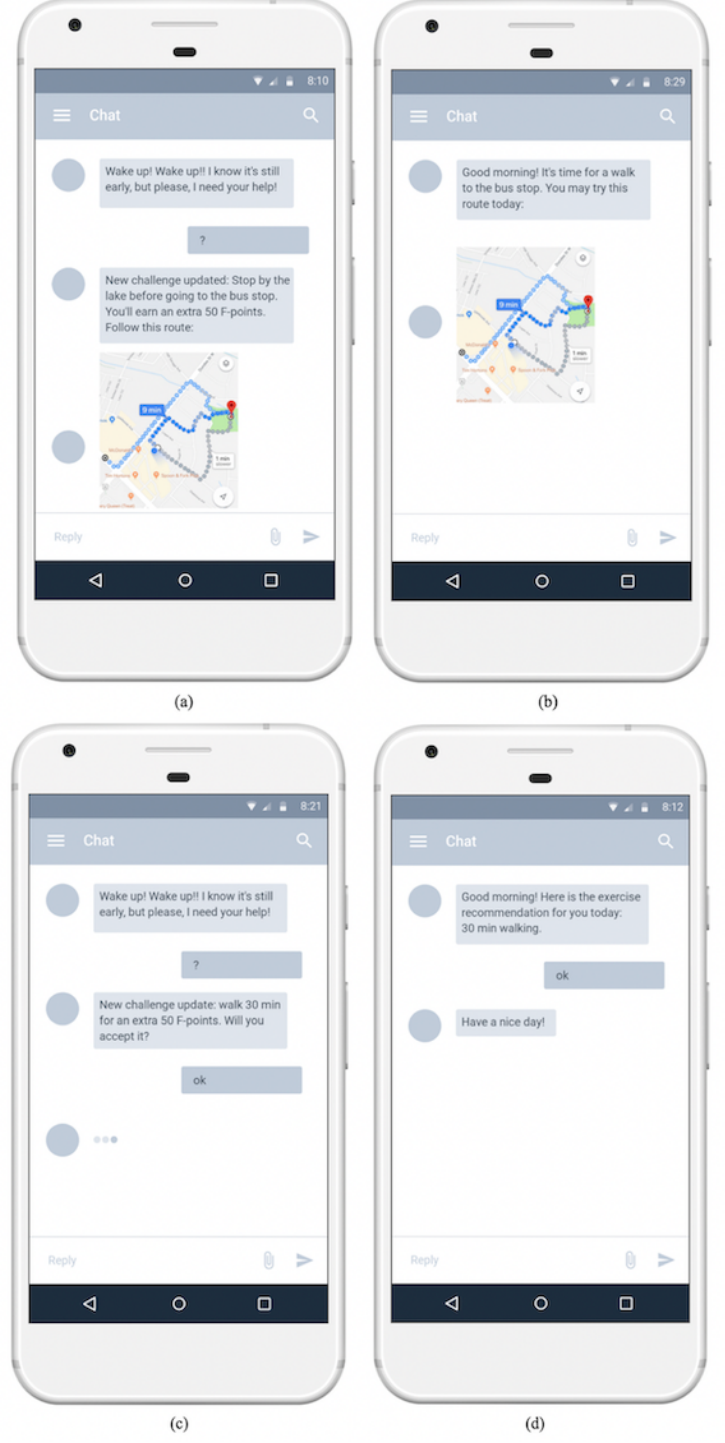
Figure 6. Example of recommendations for different groups: (a) full, (b) personalized, (c) gamified, and (d)